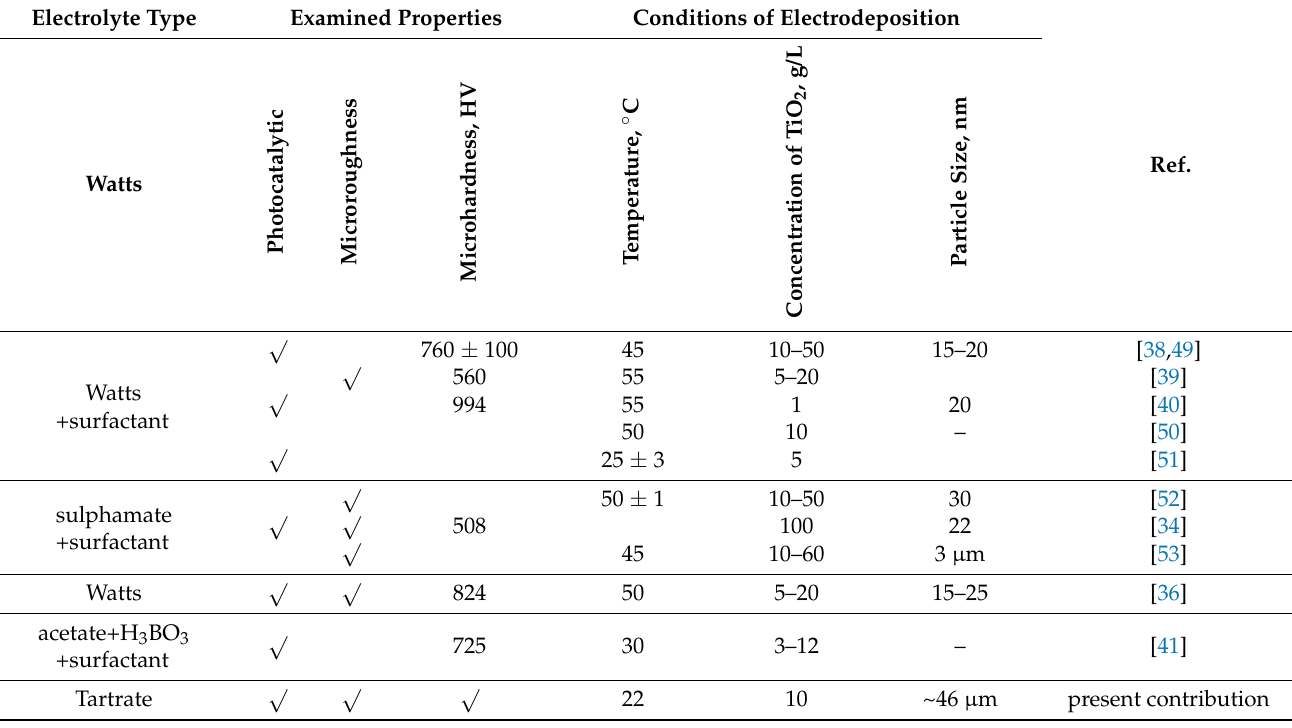
Table 2. Influence of CeO 2 nanoparticles on properties of nickel